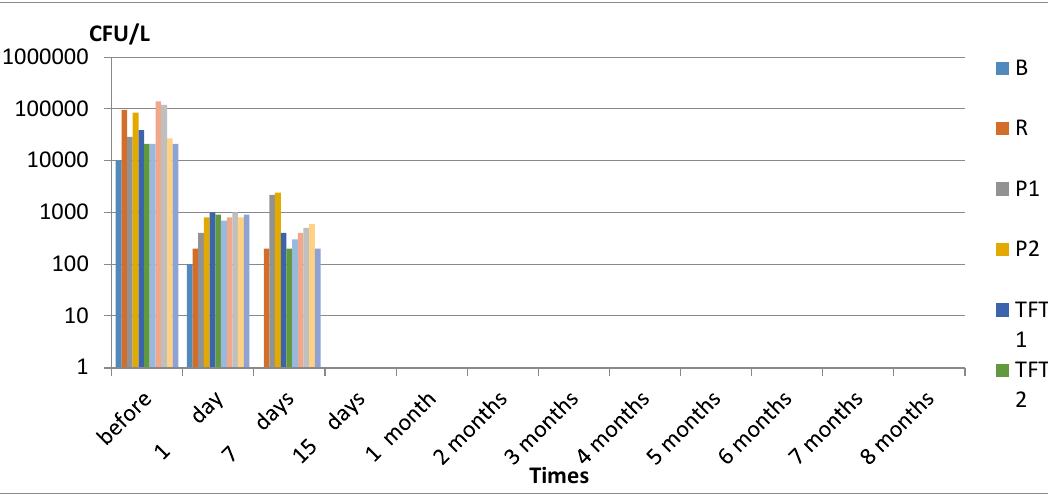
Figure 3. Legionella pneumophila sg1 counts at all the sampling points during the whole period of the study in Hospital 3. B = boiler; R = recirculation; P1 = point 1; P2 = point 2; TFT1 = time flow tap 1; TFT2 = time flow tap 2; TFT3 = time flow tap 3; TFT4 = time flow tap 4; TFT5 = time flow tap 5; TFT6 = time flow tap 6; TFT7 = time flow tap 7.